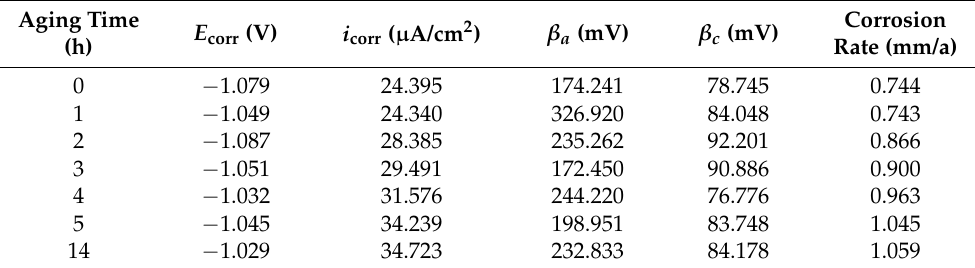
Figure 1. ( a ) Potentiodynamic polarization curves in 3.5% NaCl solution for samples aged for different times (1 h, 2 h, 3 h, 4 h, 5 h, and 14 h) at 180 °C; ( b ) breakdown potential change curve with aging time. Table 1. Electrochemical parameters of the samples in 3.5% NaCl solution, extracted from potentiodynamic polarization curves fitted in Tafel regions.